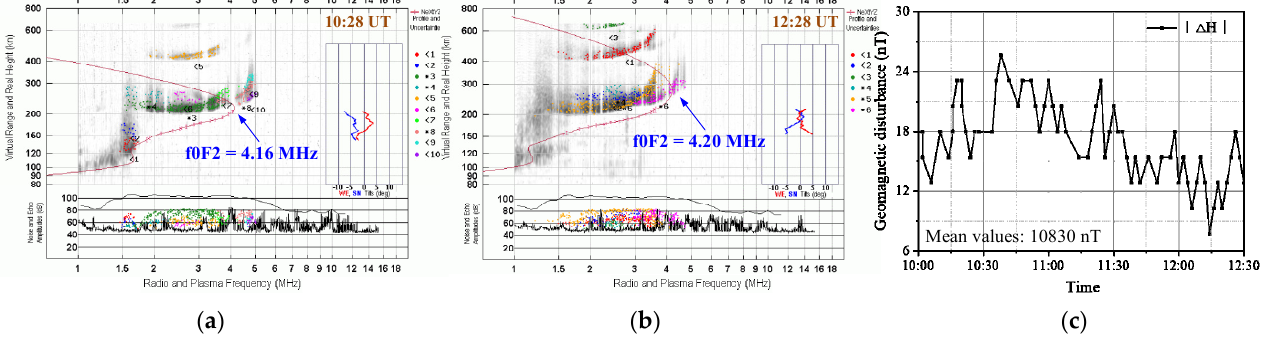
Figure 1. Results of the Dynasonde at ( a ) 10:28 and ( b ) 12:28; ( c ) relative disturbance of the horizontal geomagnetic field during the ELF/VLF ionospheric modification experiments.